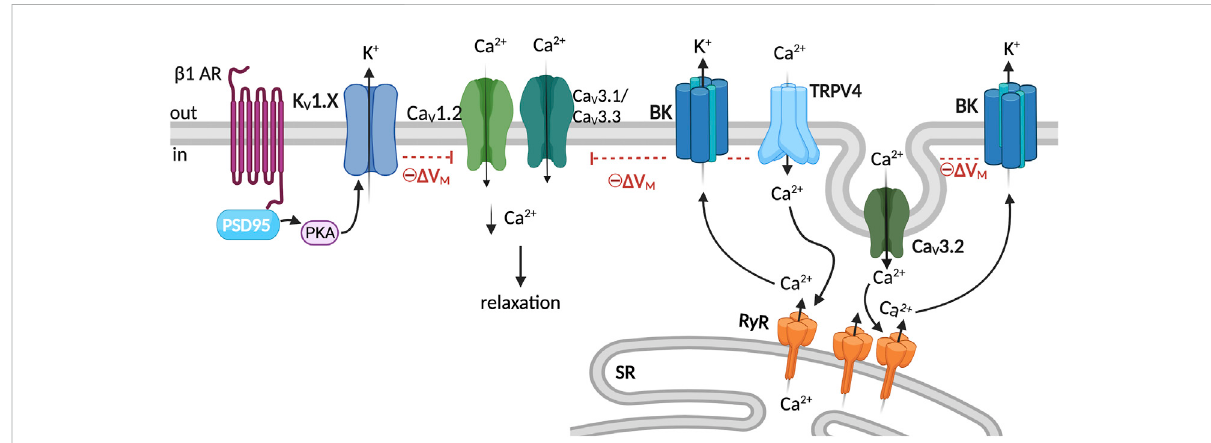
FIGURE 3 K V 1 and BK complexes and membrane potential regulation. K + channel activity provides negative-feedback regulation of membrane potential and limits Ca V 1.2 activity leading to VSM relaxation (Nelson, 1992). The scaffolding protein PSD95 facilitates the regulation of K V 1 channels by β 1AR/ PKA signaling (Moore et al., 2015). BK channels are activated by the release of Ca 2+ from the SR through RyR (Ca 2+ sparks) (Jaggar et al., 1998). Ca 2+ in fl uxthroughTRPV4channelsactivatestheRyR/BKchannelaxis,whichhyperpolarizesVSMmembranepotential(Earleyetal.,2005).Caveolae facilitate spatial proximity between Ca V 3.2 and RyR, Ca V 3.2-mediated Ca 2+ in fl ux prompts RyR, and the resultant Ca 2+ sparks activate BK channels (Harraz et al., 2014; Hashad et al., 2018), which hyperpolarizes VSM membrane potential and limits VGCC activity leading to relaxation. Graphics created with